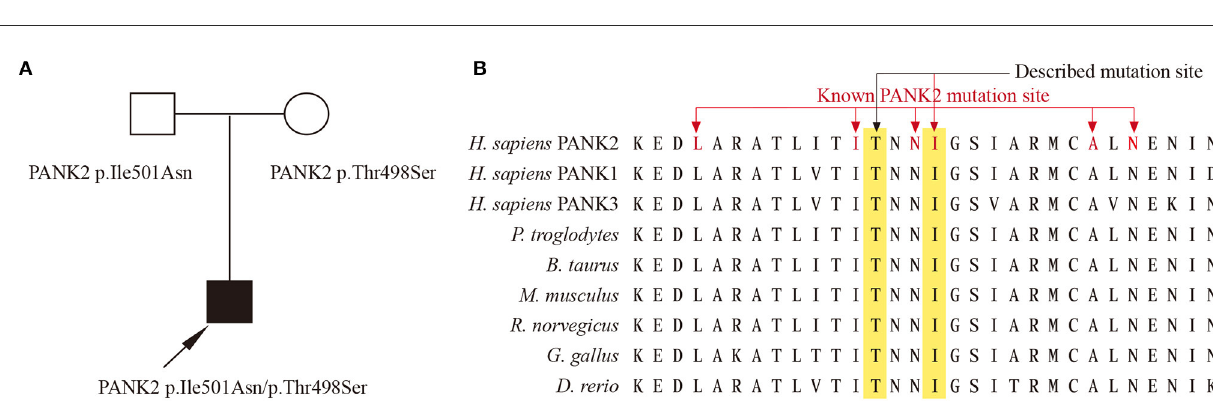
FIGURE2 (A) Family with compound heterozygous PANK2 gene variants. Proband PKAN is indicated with an arrow. (B) Amino acid sequence alignment between species and PANK family proteins, the red font indicates amino acid changes previously reported in